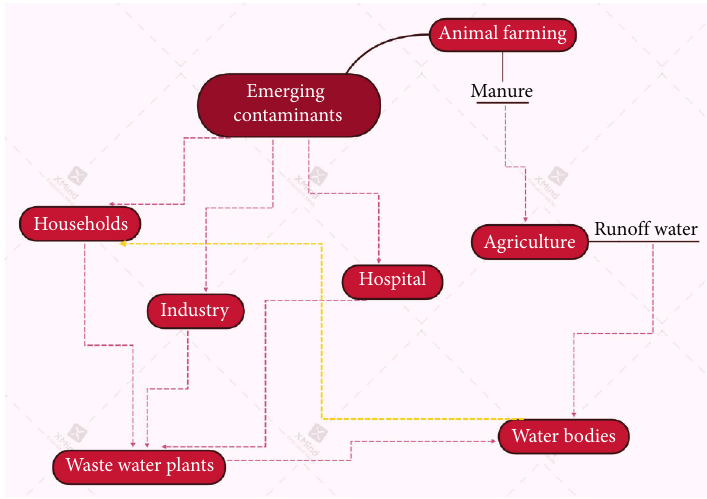
Figure 1: EC origin and